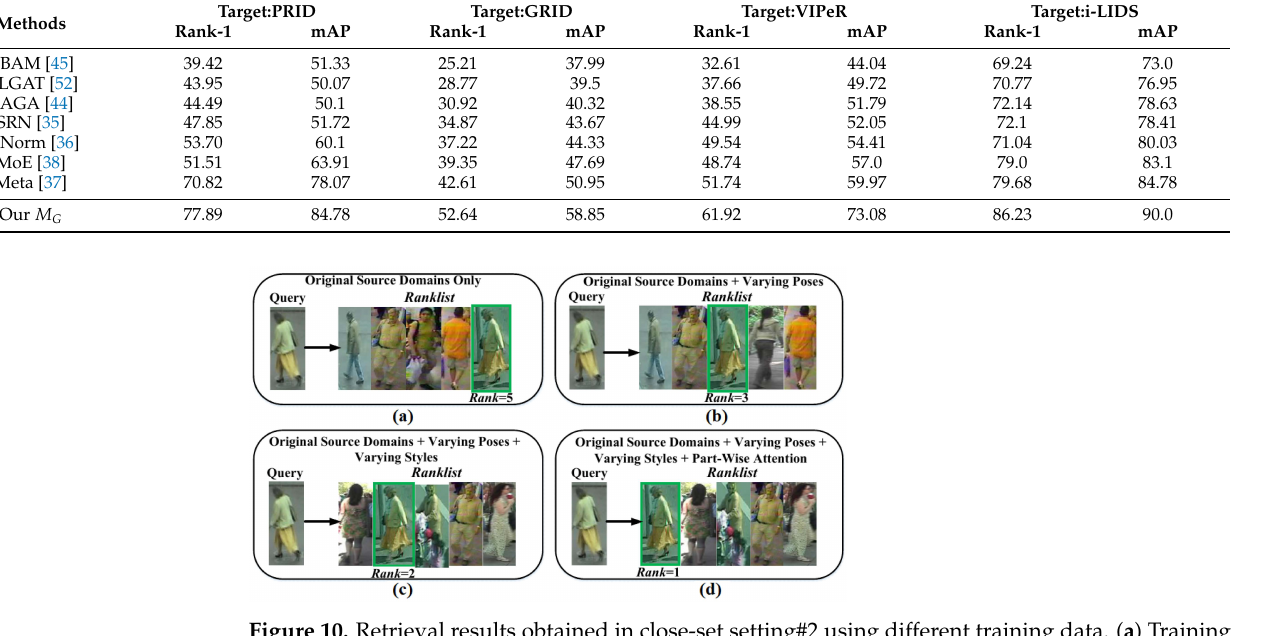
Figure 10. Retrieval results obtained in close-set setting#2 using different training data. ( a ) Training data only contains original image samples with no data augmentation; ( b ) Training data contains original image samples, and image samples are generated in different random poses too; ( c ) Training data contains original image samples, and image samples are generated in different random poses and in different random styles too; ( d ) Training data contains original image samples, and image samples are also generated in different random poses and styles, as well as, part-wise attention is learned to improve features